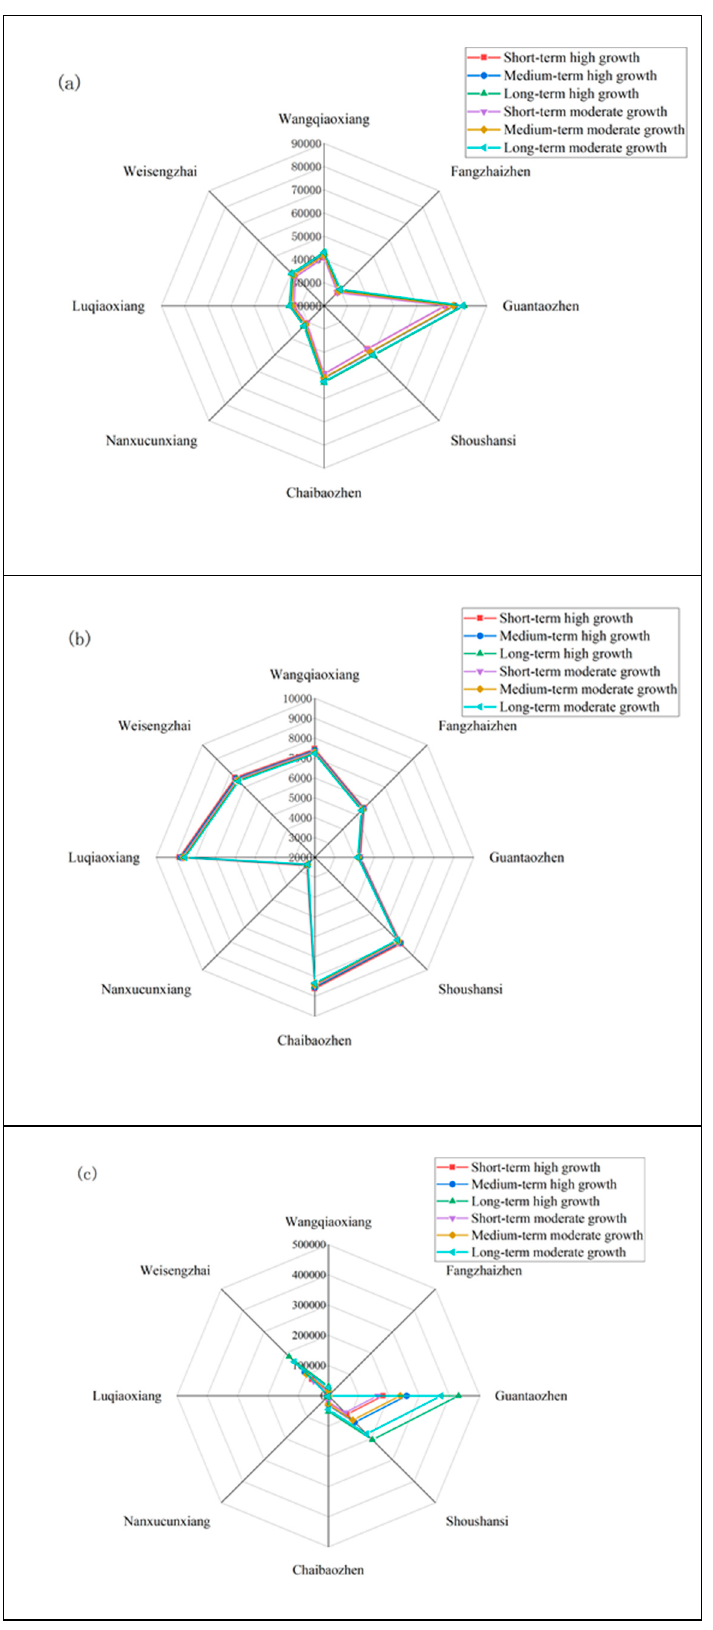
Figure 8. Social and economic development prediction: ( a ) Population prediction; ( b ) Agricultural irrigation area prediction; ( c ) Industrial added value prediction.